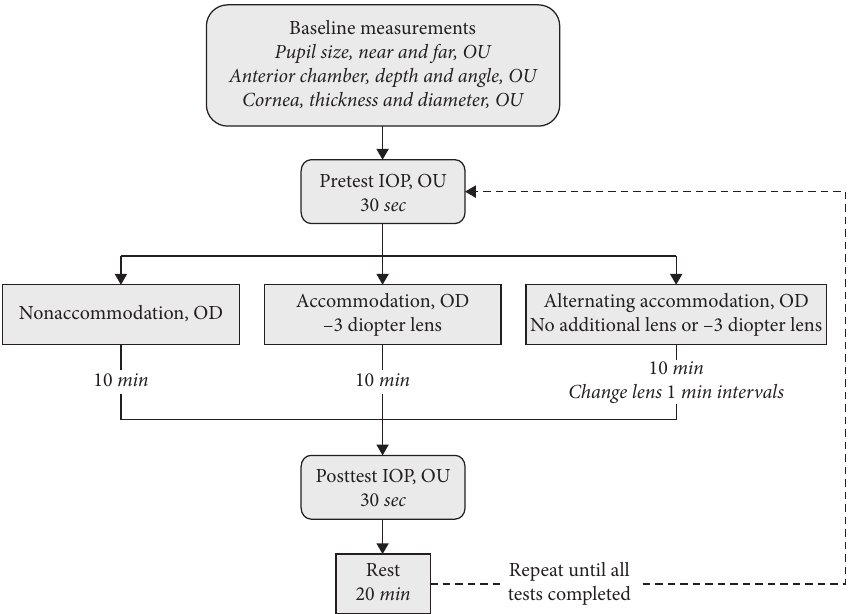
Figure 1: Study design and